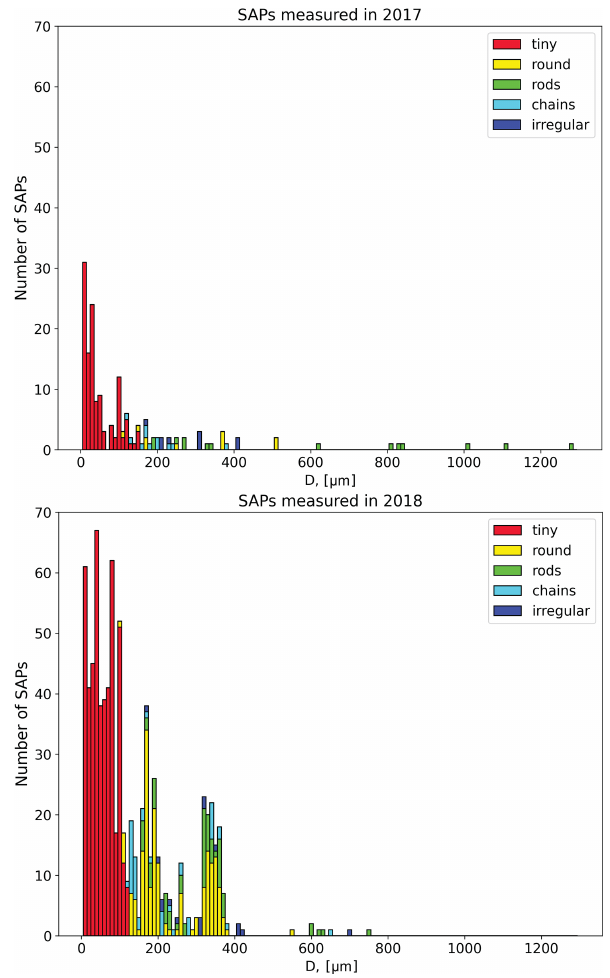
Figure 14. Particle sizes and shapes for the 165 SAPs measured in 2017 and the 692 SAPs measured in